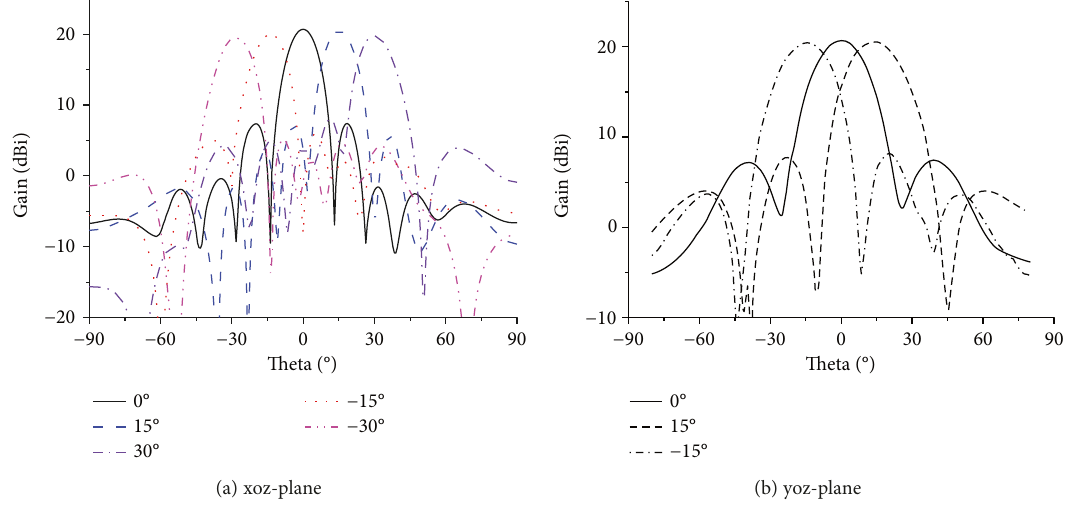
Figure 18: Measured scanning patterns of the active skin antenna prototype at 5.8GHz. Table 5: Electrical performance indexes of active skin antenna under undeformed conditions.